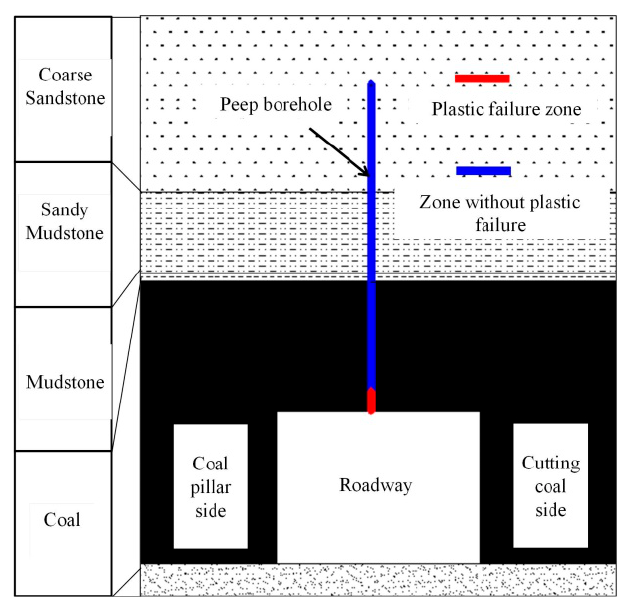
Figure 4. Roof rupture of the roadway before mining.